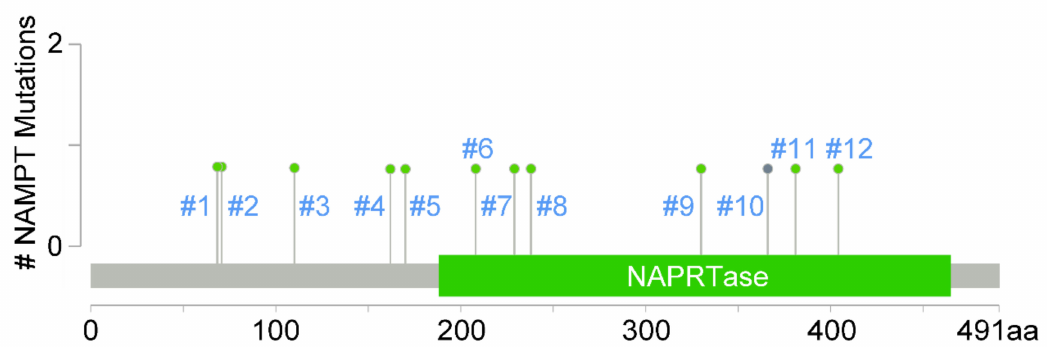
Figure 2. A pancancer study of whole genomes revealing types and sites of NAMPT gene muta- tions. Mutation diagram circles are highlighted by colors with respect to the specific mutation types. Light green indicates missense mutations (unknown significance). Gray indicates truncating muta- tions (putative driver), including frameshift deletion, nonsense, nonstop, and frameshift insertion